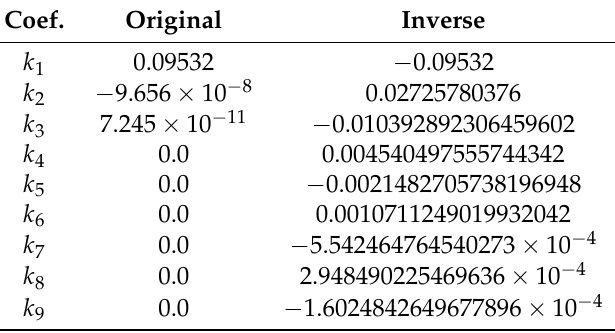
Table 4. Radial distortion comensation and then application of the inverse used with the image taken with the P32